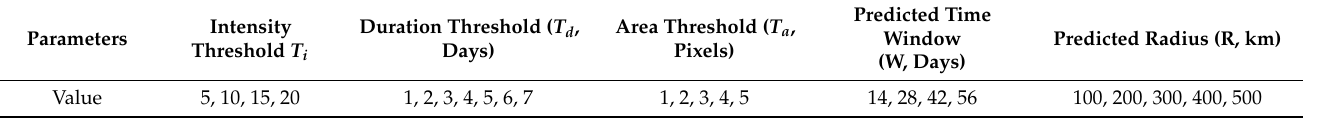
Table 4. The statistical evaluation of the algorithm with different parameters.